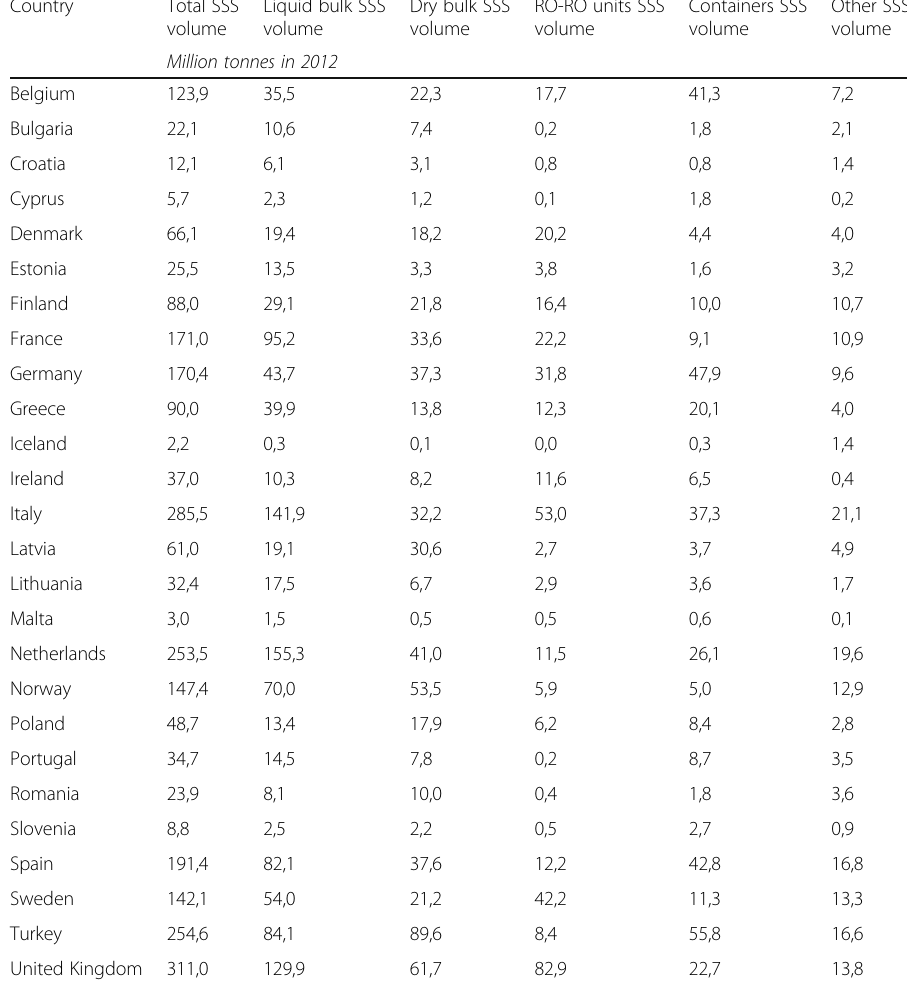
Table 1 SSS volume per European country and per segment in 2012